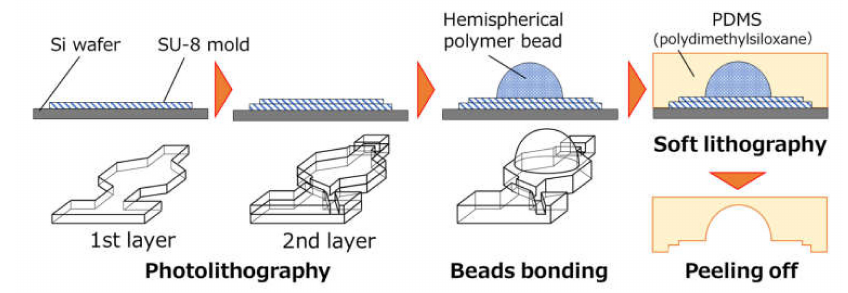
Figure 2. Fabrication process for a PDMS-based microfluidic diagnostic device fabricated by a modified soft-lithography process assisted with hemispherical polymer beads to create deep localized microchamber